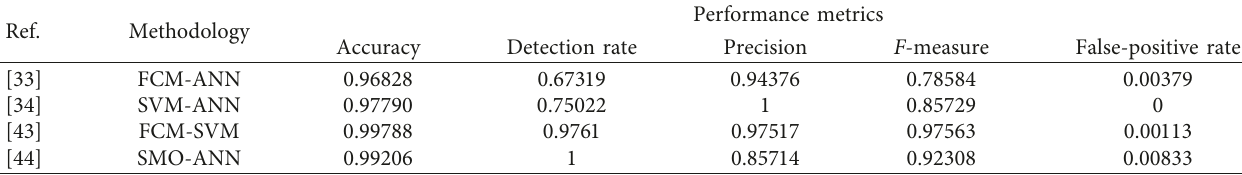
Table 10: Comparison of various methodologies based on different performance metrics for reconnaissance attack. Ref.